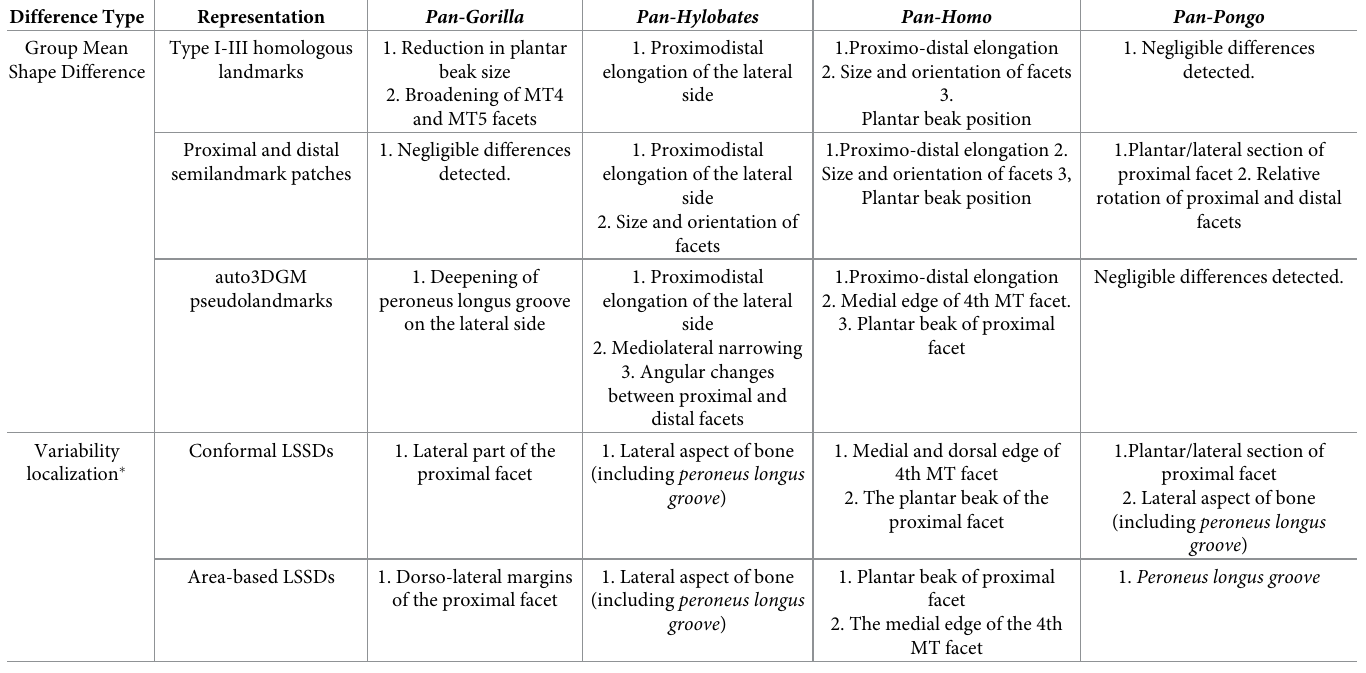
Table 2. Prominent between-group shape differences detected in representations from each